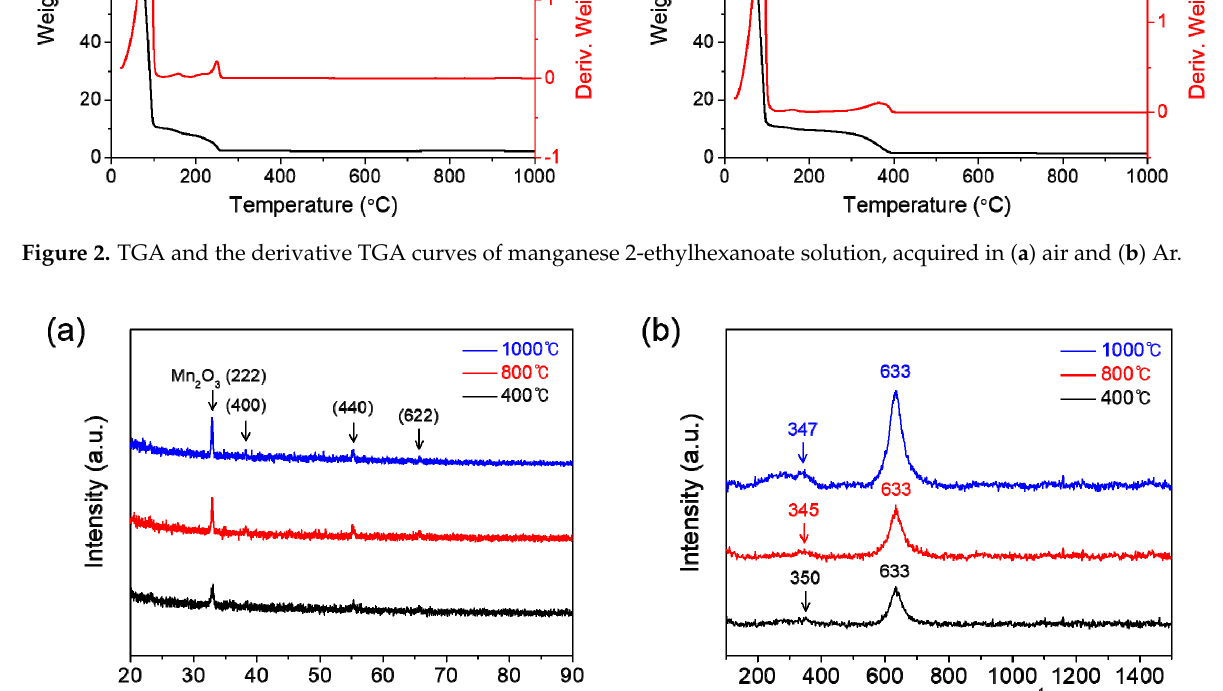
Figure 3. ( a ) XRD patterns and ( b ) Raman spectra of the manganese oxide (Mn 2 O 3 ) films prepared at various calcination temperatures of 400, 800, and 1000 °C for 1 h in air.